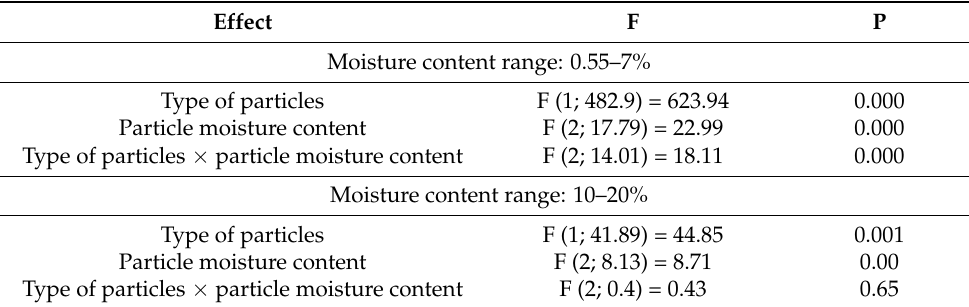
Figure 7. The angle of repose and the slippery angle of repose of microparticles ( a ) and particles of the core layer of particleboard ( b ) depending on their moisture content (a, b, c …—homogeneous groups as determined by the Tukey test). Table 2. Multivariate significance tests of the MP and PCL particle angle of repose.